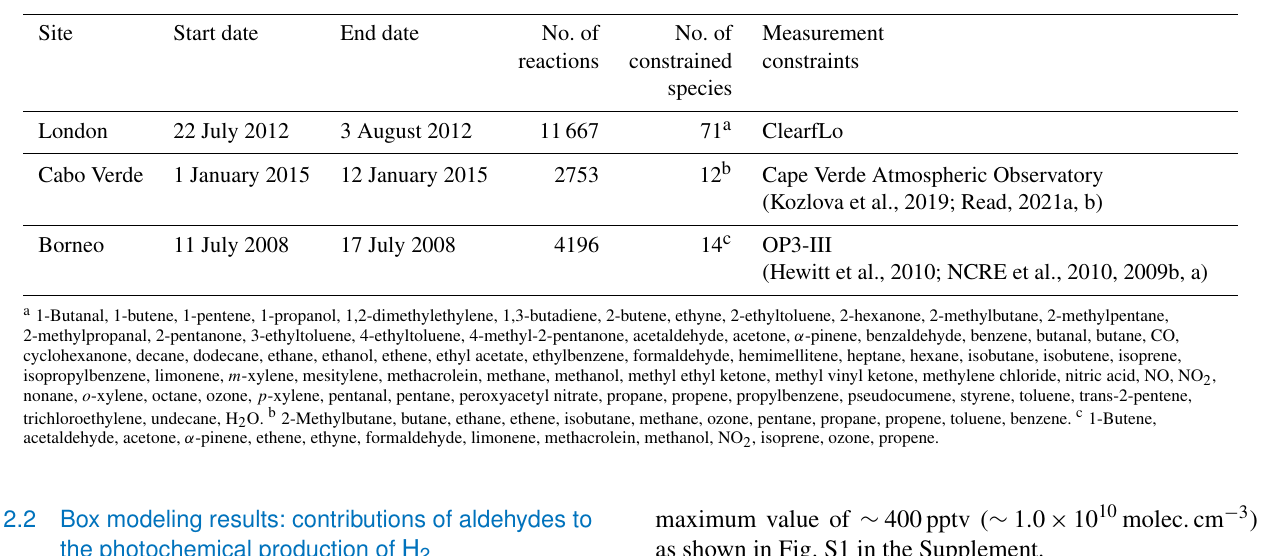
Table 1. Summary of the box model